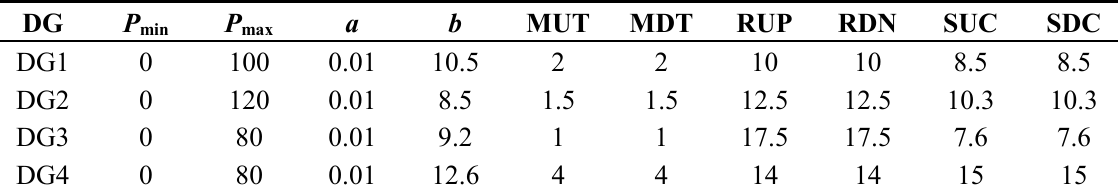
Figure 3. The single line diagram of VPP test system. Table 1. The characteristic parameters of DGs.